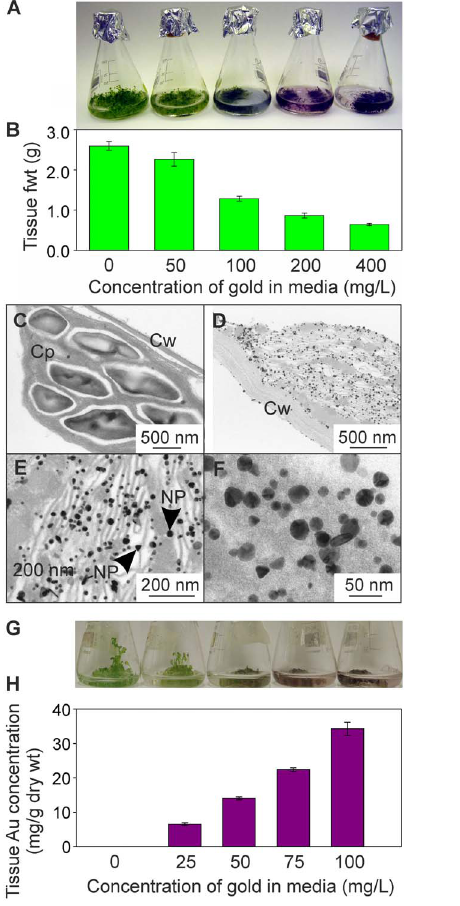
Figure 2. Uptake of gold by Arabidopsis from hydroponic culture. (A) Appearance of three-week-old, liquid-culture grown Arabidopsis plants dosed for 24 h with a range of gold concentrations, as K(AuCl 4 ). (B) Levels of gold in plant tissues 24 h after treatment. Results are the mean from five biological replicates 6 SE. Transmission electron microscopy images of plants dosed with 200 mg/L gold, as K(AuCl 4 ). (C), chloroplasts from untreated plants; (D–F) chloroplasts from NP, nanoparticle; Cy, cytoplasm; Cw, cell wall. (G) Appearance of three-week-old, liquid-culture grown Arabidopsis plants dosed for 24 h with a range of gold concentrations, as K(AuCl 4 ). (H) Levels of gold in plant tissues 24 h after treatment. Results are the mean from four biological replicates 6 SE.